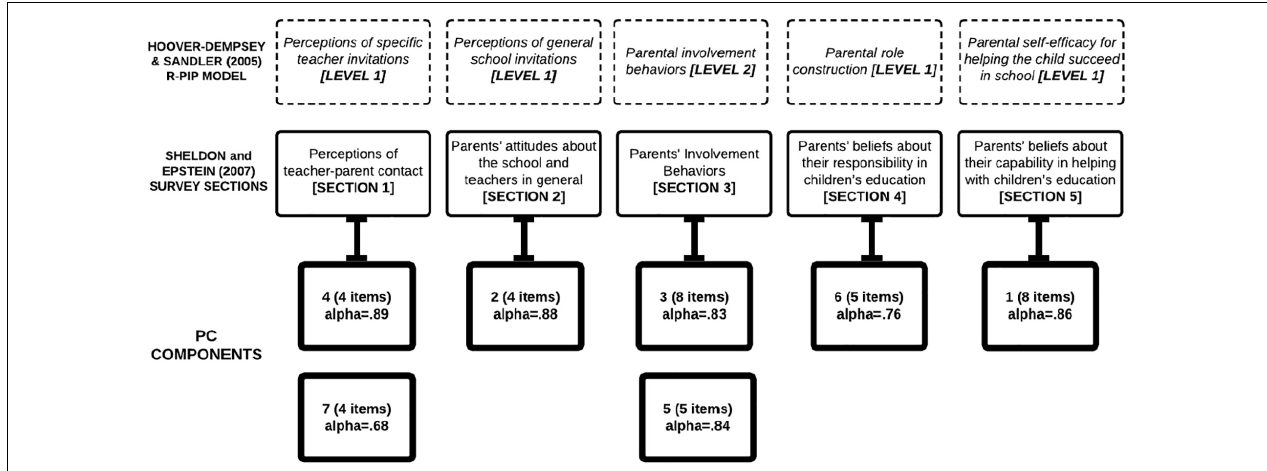
FIGURE 3 | Mapping of Hoover-Dempsey and Sandler (2005) R-PIP model in top Row, Sheldon and Epstein (2007) survey section in middle row with principal components (PC) in bottom